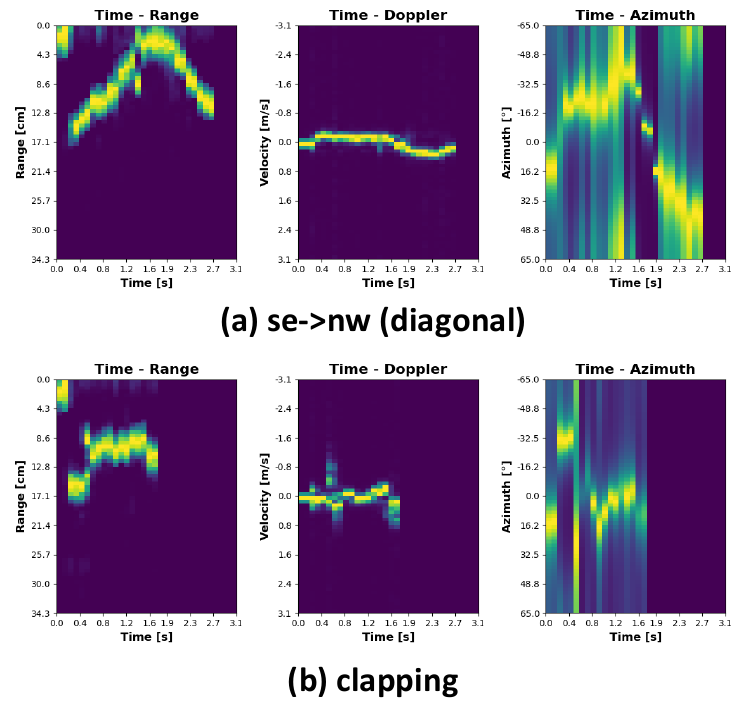
Figure 11. Gesture signatures cont.